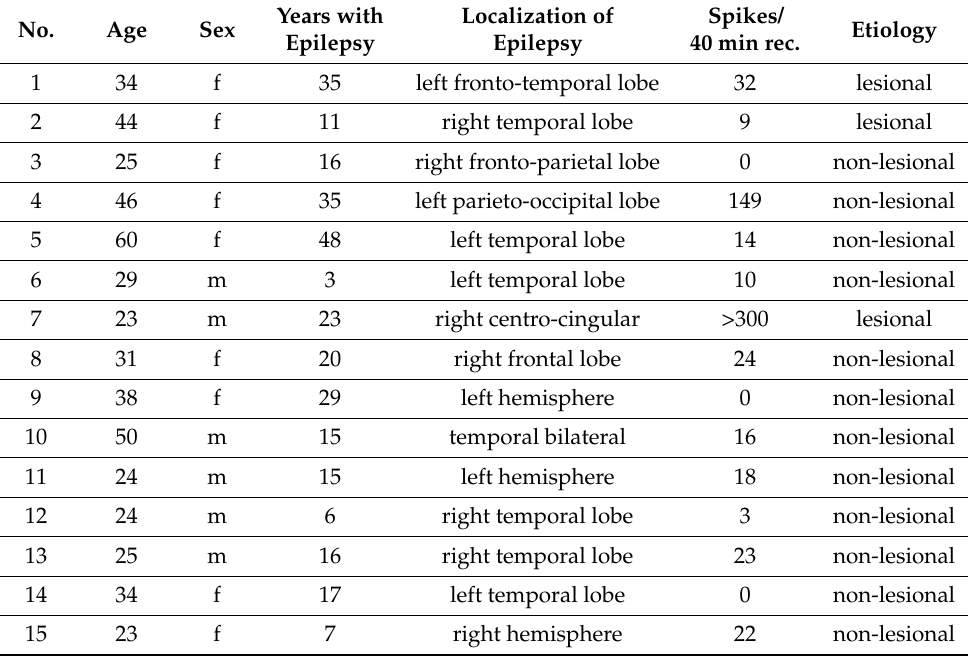
Table 1. Patient